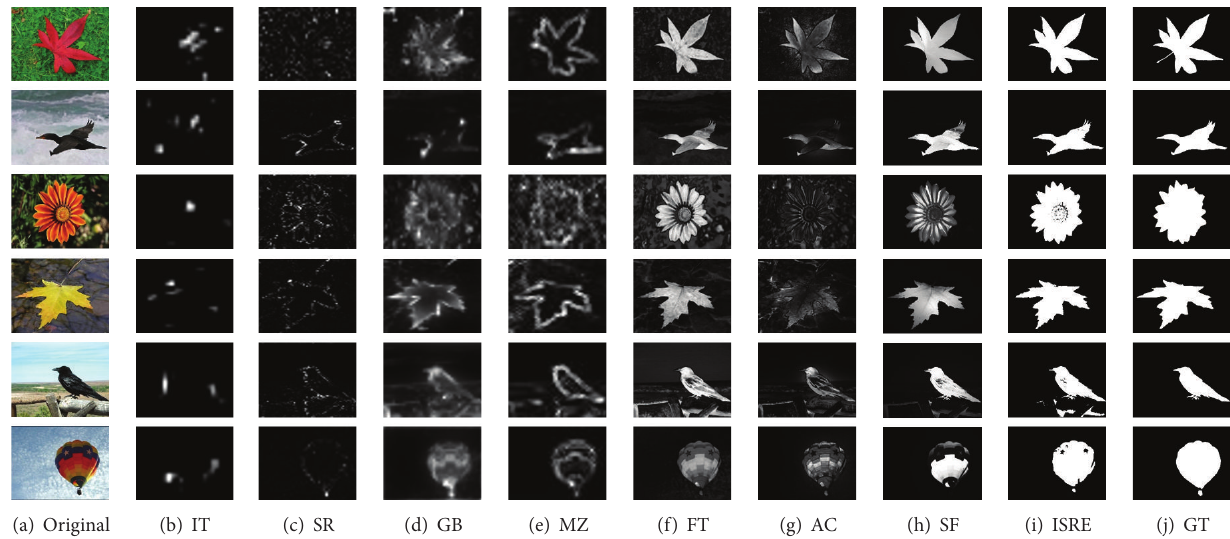
Figure 4: Contrast experiment among the seven existing algorithms, the ground truth, and ISRE.